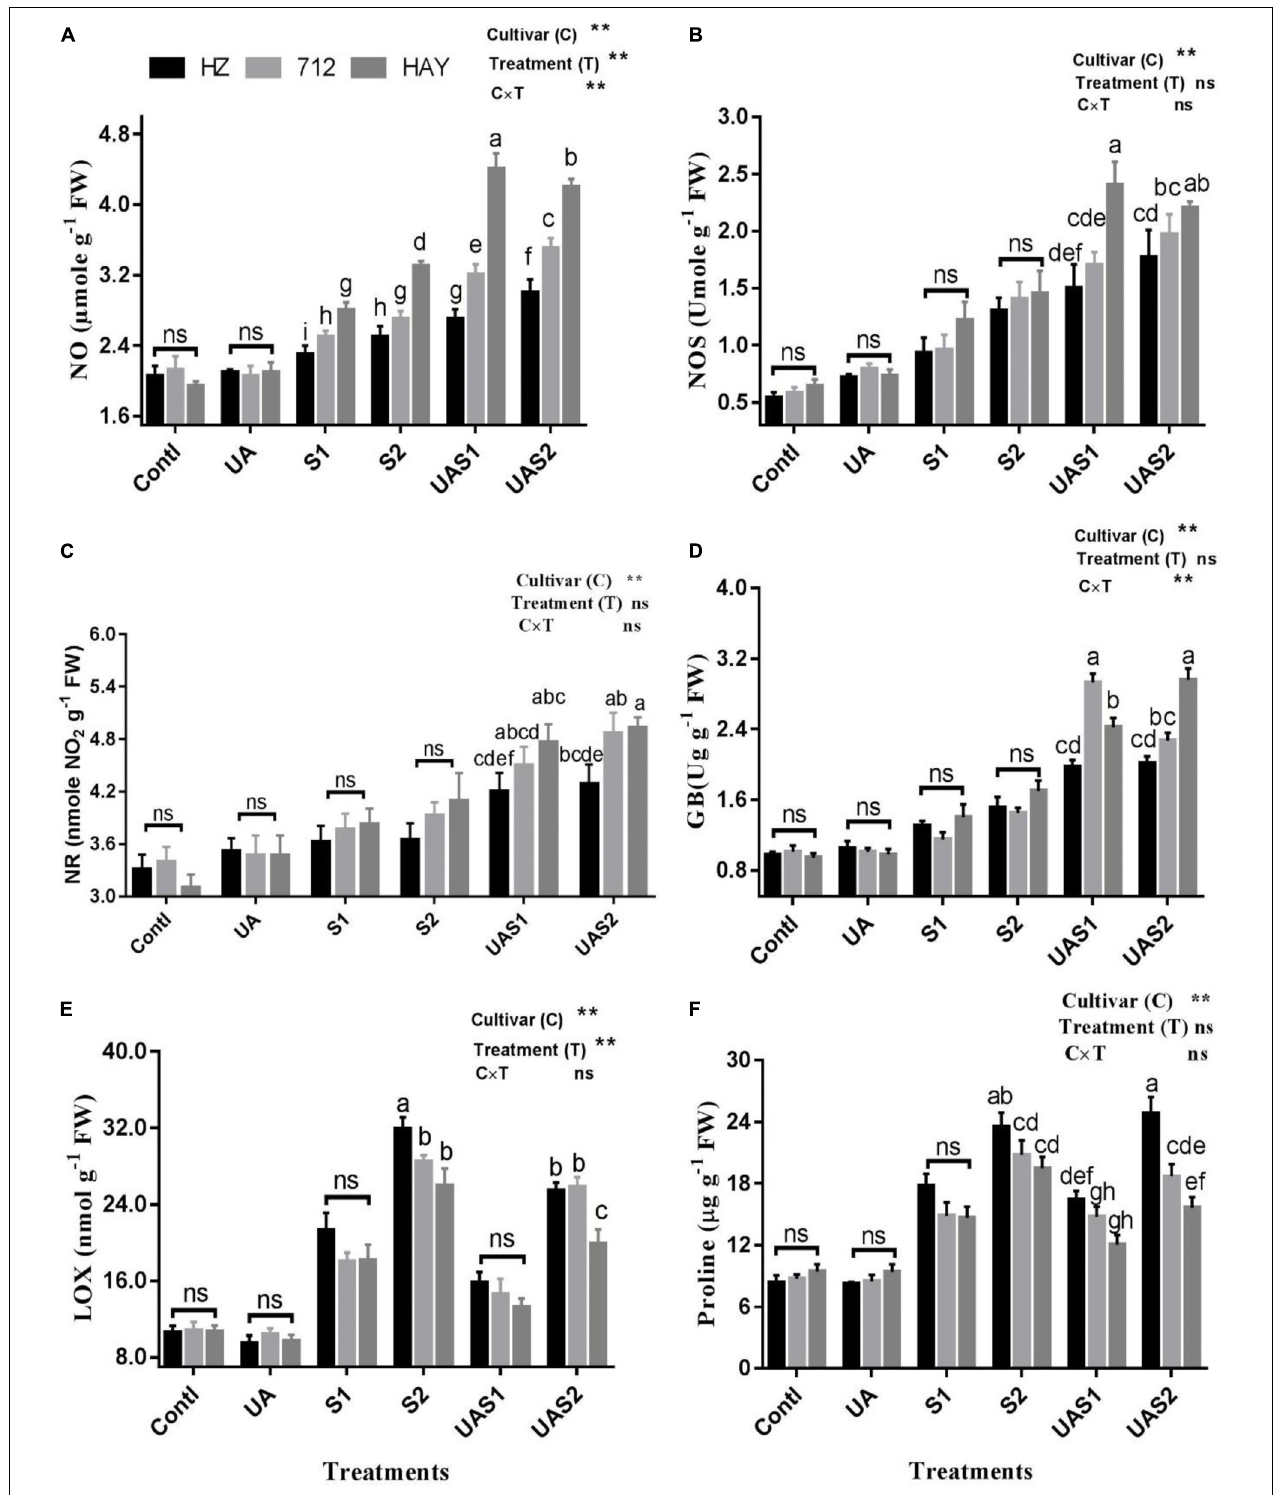
FIGURE 2 | Effect of ursolic acid (UA) on nitric oxide metabolism (A–C) , GB (D) , LOX (E) and proline (F) contents in three rice cultivars (HZ, 712, and HAY) under different salinity treatments. Means with the same letters are not significantly different based on two-way ANOVA followed by Duncan’s test ( p ≤ 0.05) for each cultivar at different salt stress treatments. The results show the mean ± SE of five replicates, and three/four plants were bulked for each replicate. Error bars represent the standard error. Contl = Control, UA = ursolic acid. S1 = 4 dS m − 1 , S2 = 8 dS m − 1 , UAS1 = ursolic acid + 4 dS m − 1 , UAS2 = ursolic acid + 8 dS m − 1 . p ≤ 0.05 (*); p ≤ 0.01 (**); ns: not statistically significant ( P >